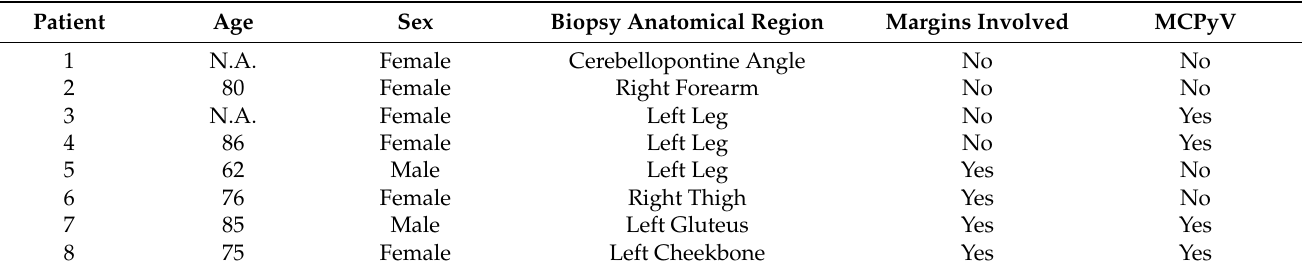
Table 1. Characteristics of the study